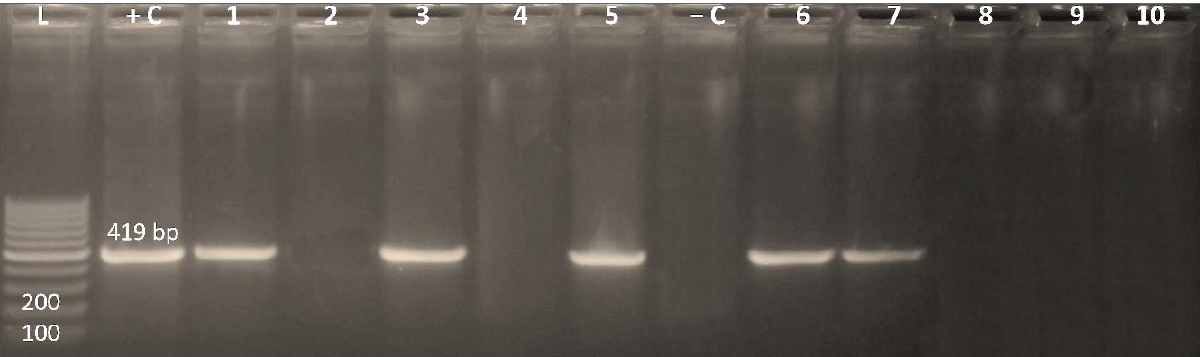
Figure 1. Agarose gel electrophoresis of the integrase gene among Enterobacterales isolates. Lane L: 100-bp ladder; +C: positive control; − C: negative control; lanes 1, 3, 5, 6 and 7: positive integrase targeted at 491